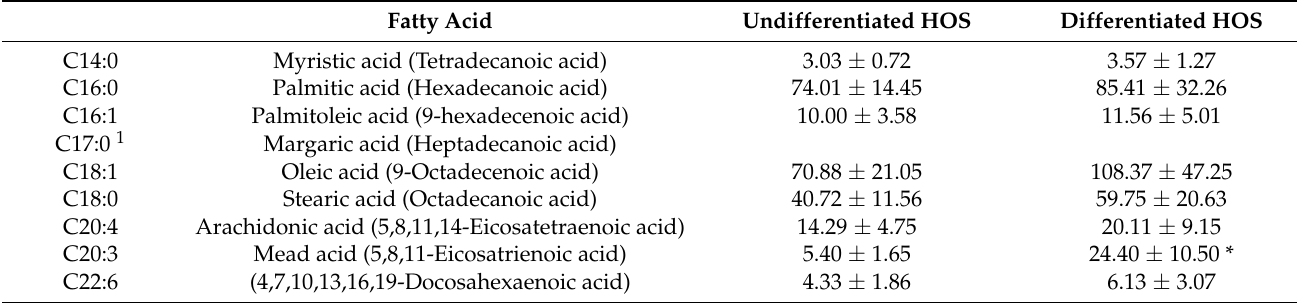
Figure 7. Representative GC chromatograms of fatty acids extracted from ( a ) undifferentiated HOS and ( b ) differentiated HOS cell culture. Fatty acids detected in HOS are labeled on chromatograms. Differences in chromatographs are extracted for each sample. Table 2. Fatty acids detected in cell samples. Values are expressed as a percentage of IS ± sd. Difference according to t -test significant between two cultures, * p < 0.05.